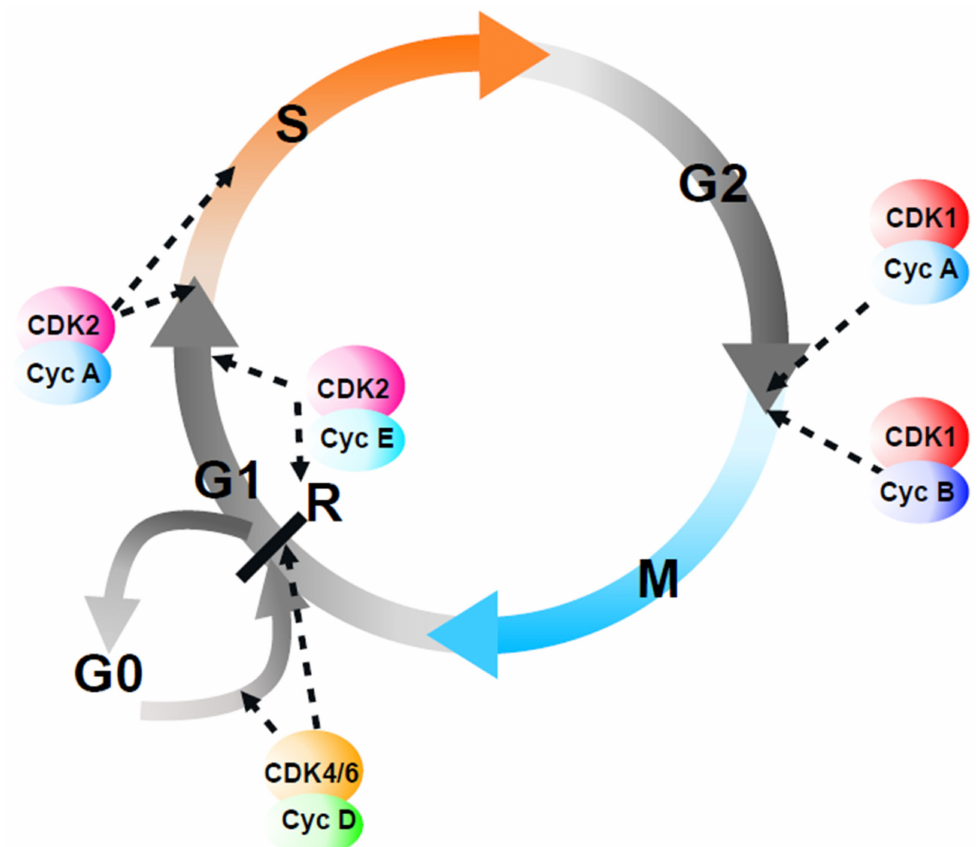
Figure 1. A popular representation of cell cycle control by CDKs. In this “popular” model, the vertebrate cell cycle is viewed as a unidirectional passage through four distinct phases, each one controlled by specific CDK–cyclin complexes that act sequentially (dashed arrows). At a point in mid-G1, the “restriction point” (R), if CDK2 and CDK4/6 activities are sufficient, cells continue into the next cell cycle; otherwise, they exit the cell cycle into a quiescent state (G0). As discussed in the text, this model has numerous